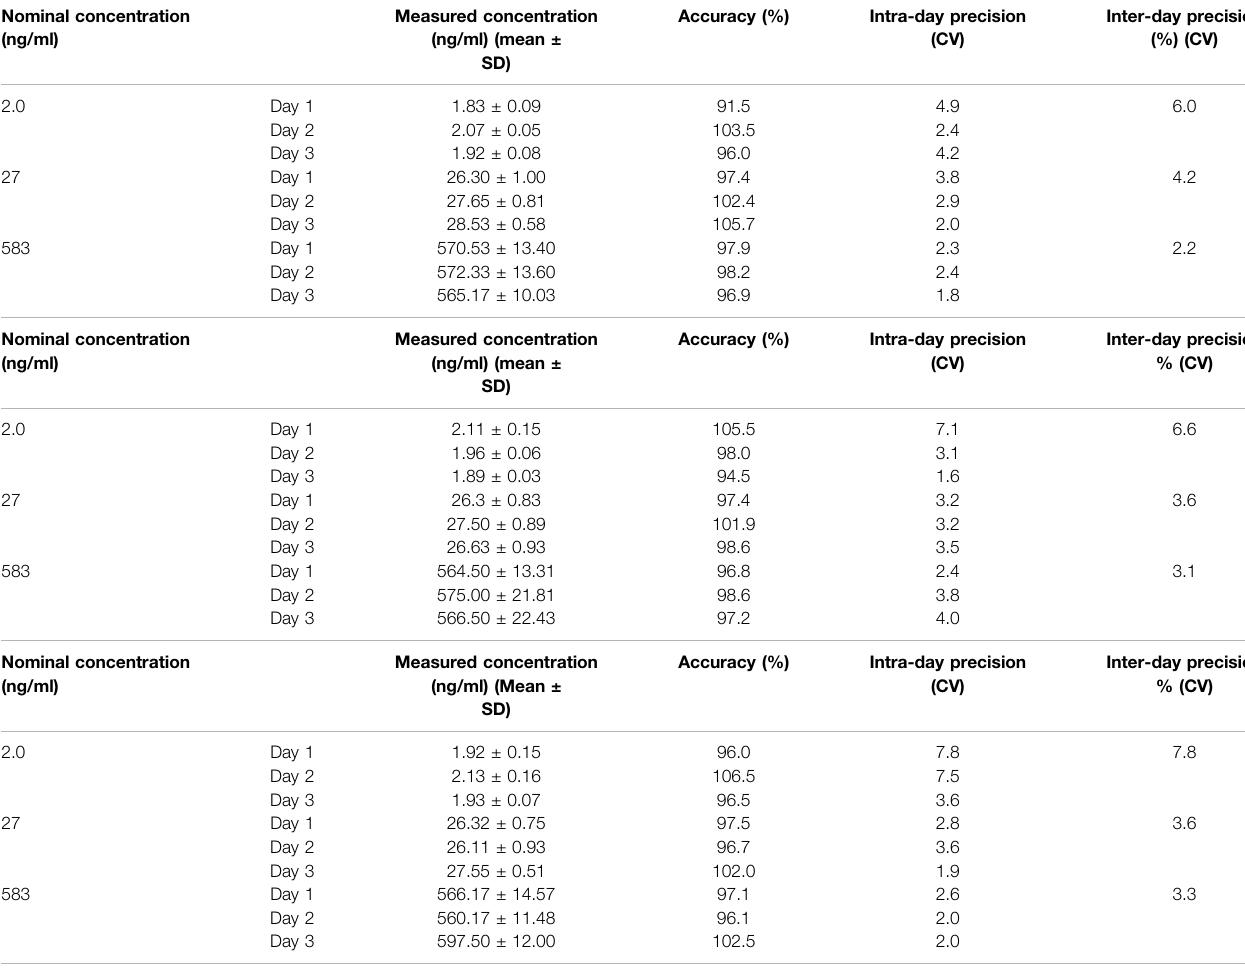
TABLE 2 | Accuracy and intra- and inter-day precision of (A) osimertinib, (B) AZ-5104, and (C) AZ-7550 in SD rat plasma ( n = 6). (A) Nominal concentration (ng/ml)